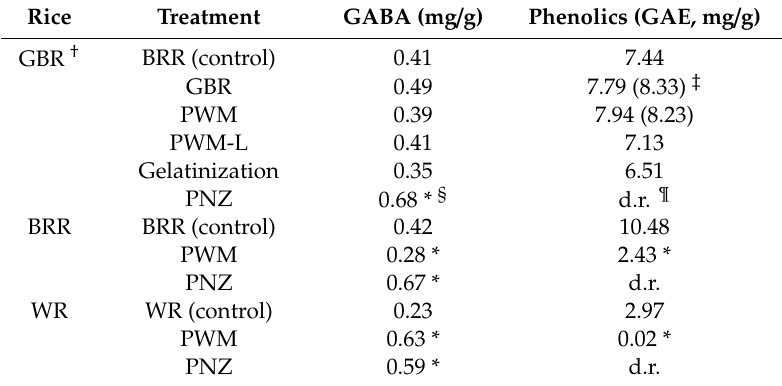
Table 4. Statistical analysis of γ -aminobutyric acid and phenolic mean di ff erences assessing the e ff ects of processing brown Rondo rice into beverages.